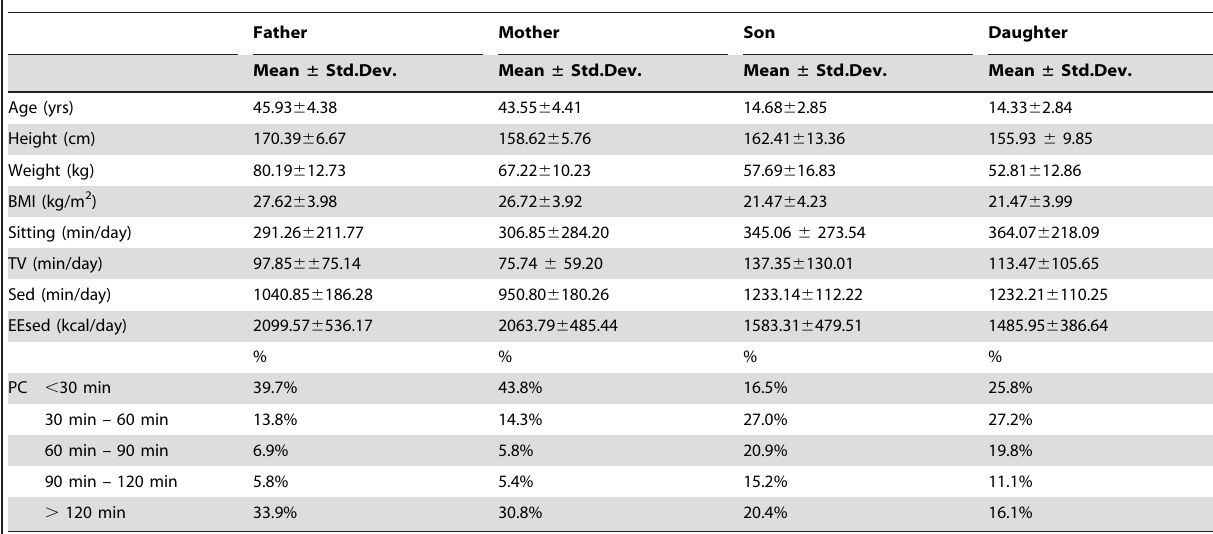
Table 1. Sample descriptive statistics.